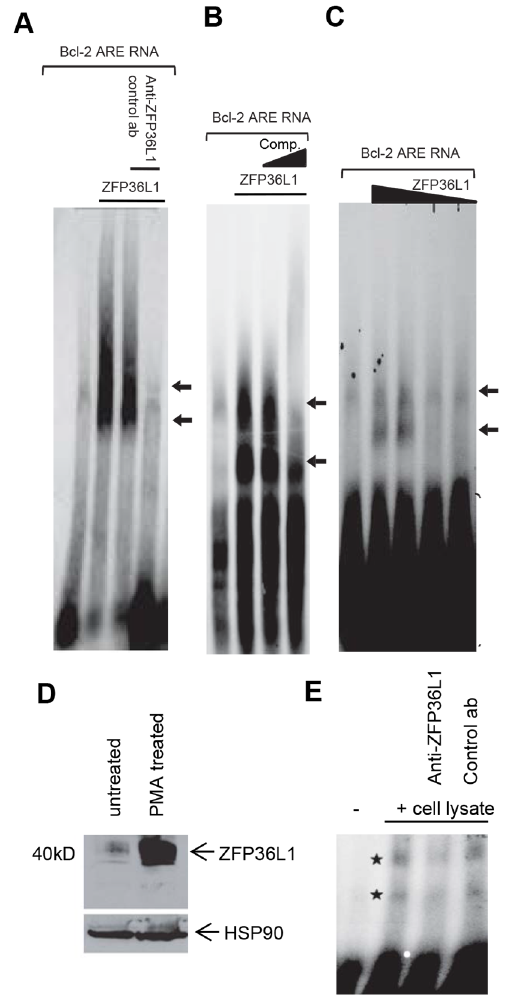
Figure 3. RNA electrophoretic mobility shift analyses of ZFP36L1 binding to the BCL2 ARE. (A) REMSA analysis of recombinant ZFP36L1 binding to BCL2 ARE RNA probes (see Methods). 50 ng of purified recombinant ZFP36L1 protein was incubated with 32 P- labeled BCL2 ARE. The specificity of RNA-protein complexes were examined by addition of 80 ng of anti-ZFP36L1 antibody (Cell Signaling Technology rabbit-anti-human ZFP36L1/L2 antibody) or a non-specific control (rabbit IgG) for 10 min prior to addition of radiolabeled probes as indicated (B) REMSA analysis of recombinant ZFP36L1 binding to BCL2 ARE probes, using cold competition. 50 ng of purified